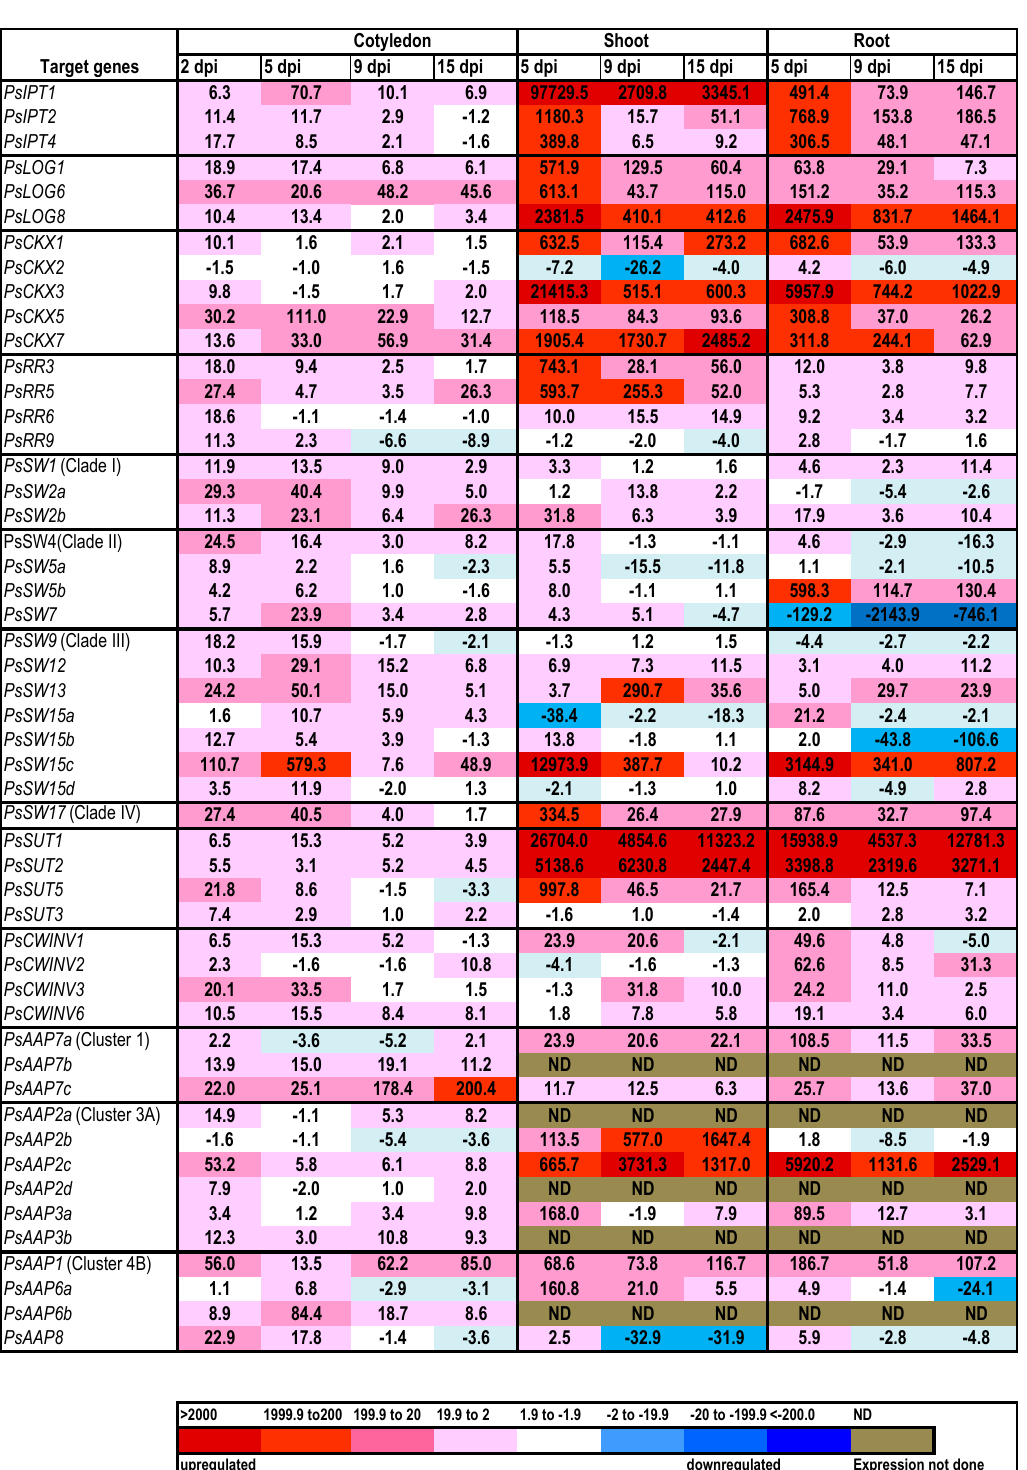
Figure 2. Relative expression of cytokinin biosynthesis ( PsIPT ), activation ( PsLOG ) degradation ( PsCKX ) and response regulator ( PsRR ) gene family members along with PsSWEET , PsSUT , PsCWINV and PsAAP gene family members in Pisum sativum cotyledons at two days post-imbibition (dpi), and in cotyledons, shoots and roots at 5, 9 and 15 dpi. Values are fold-changes relative to the expression at four hours post-imbibition (4 hpi). The colour scale indicates up-regulated expression (red scale), similar (white) and down-regulated expression (blue scale) relative to 4 hpi.